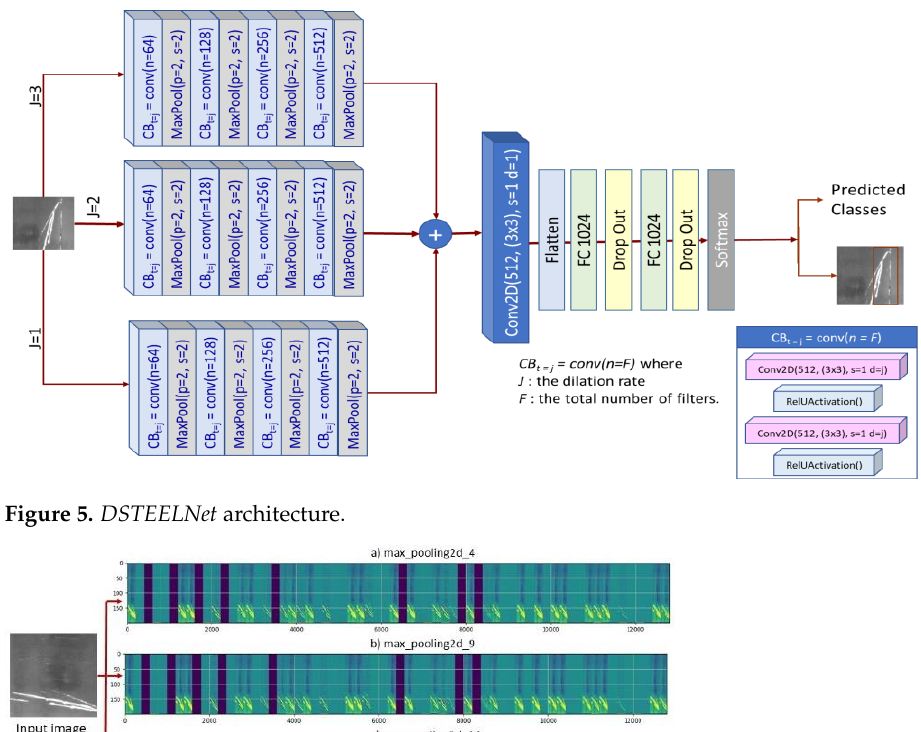
Figure 5. DSTEELNet architecture.